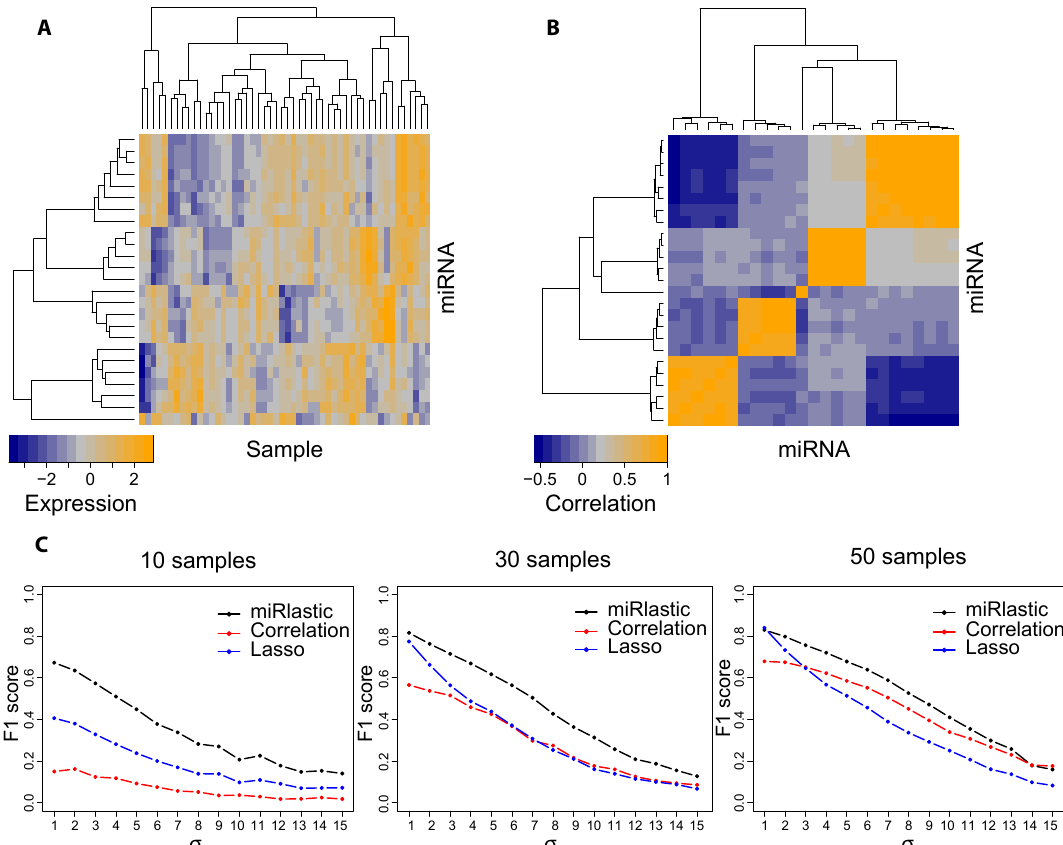
Figure 4. Benchmark with synthetic data. ( A ) Heatmap illustrating a set of randomly generated synthetic miRNAs with 30 samples; ( B ) Heatmap of pairwise correlations between the generated miRNAs; ( C ) Success-rate ( F 1 ) of all algorithms across varying sample numbers and noise levels to recover the true synthetic mi-/mRNA